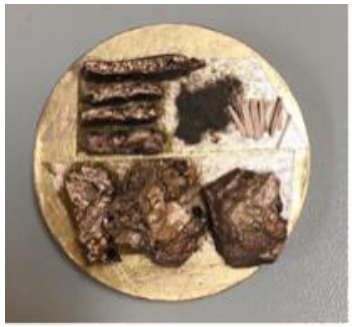
Figure 7. SEM test Figure 7. SEM test samples.